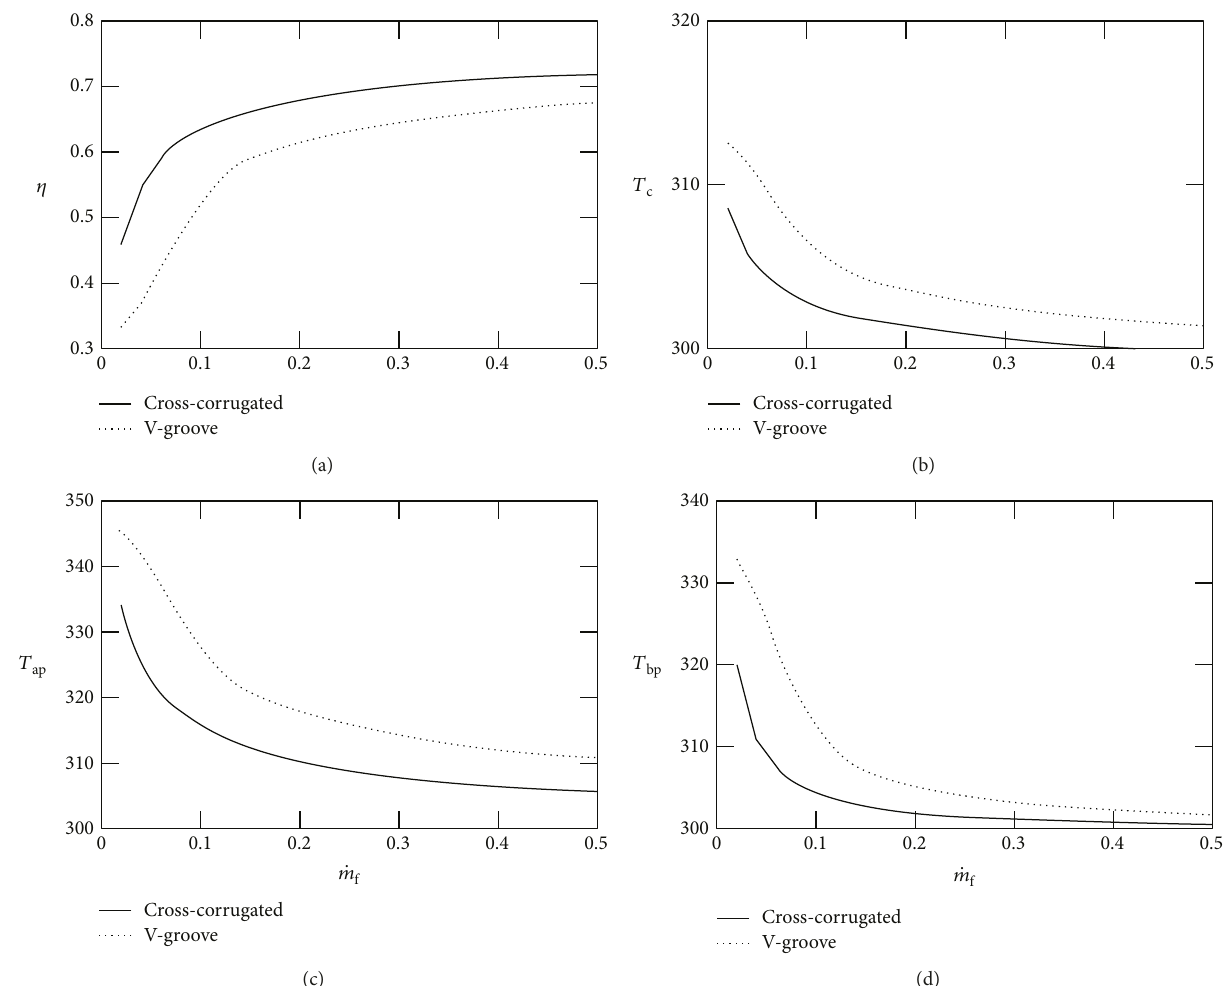
Figure 3: (a – d) E ffi cient heat removal by cross-corrugated compare to V-groove collector, Liu et al. [28].